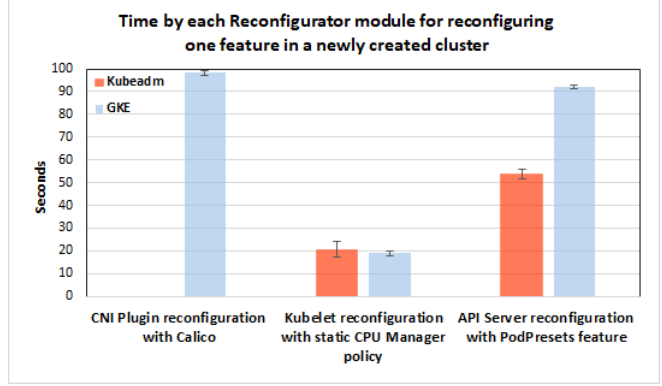
Figure 15. Reconfiguration time for each feature in a newly created